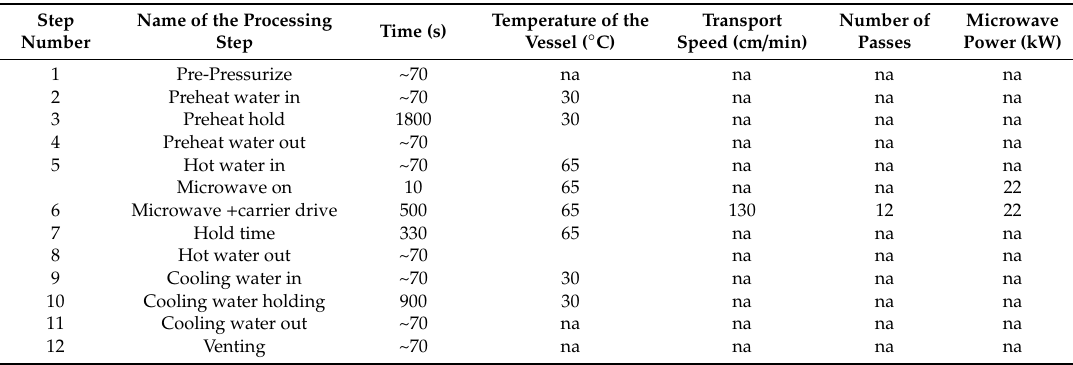
Table 2. The processing steps for